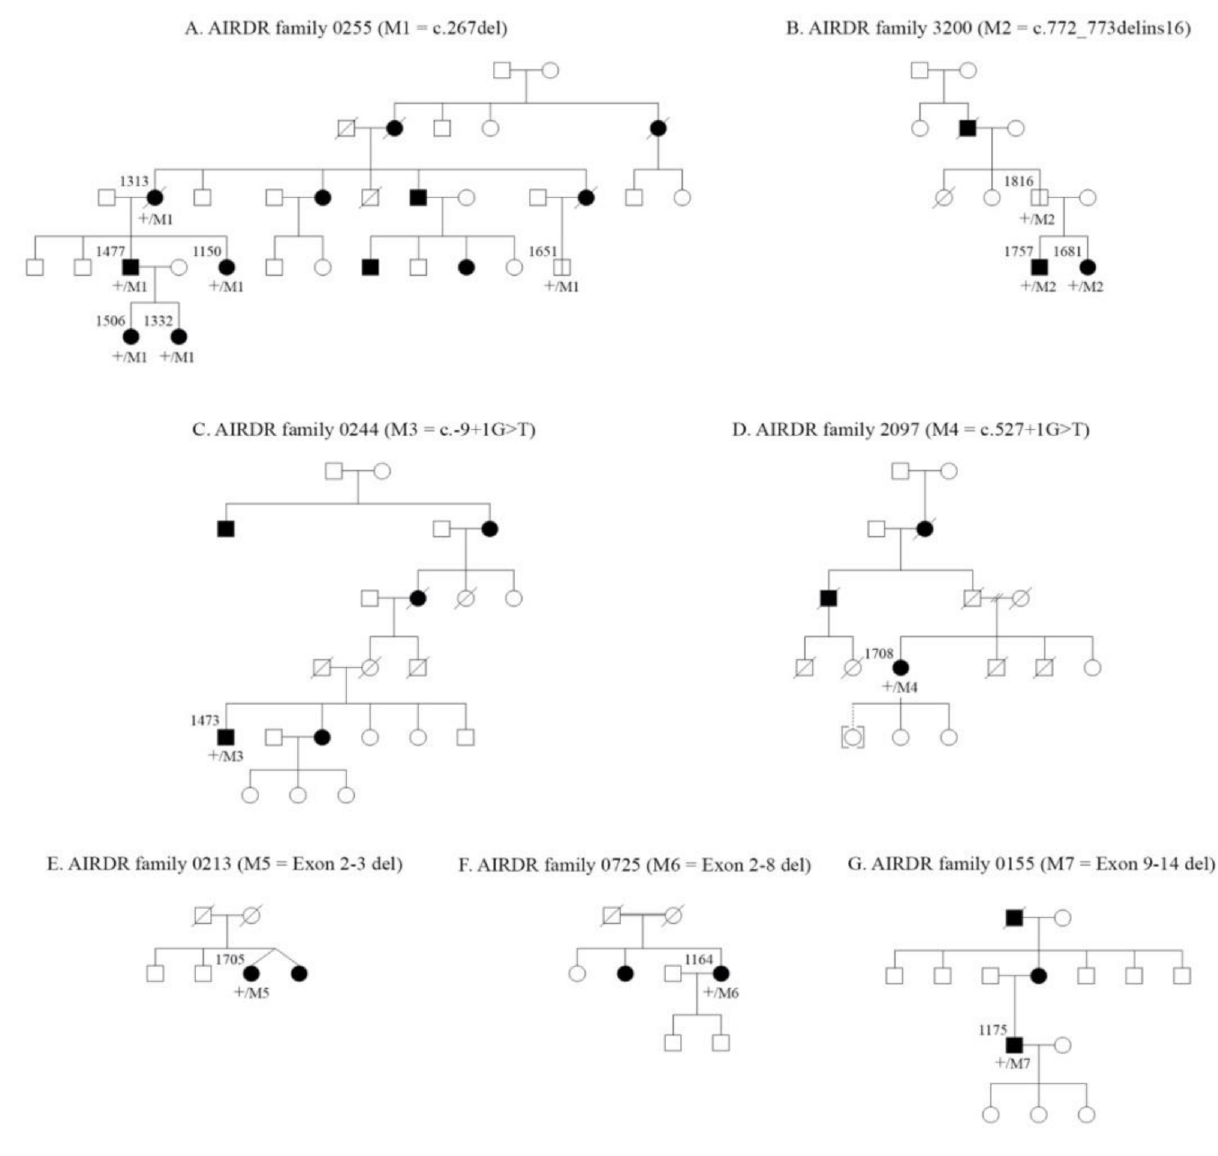
Figure 1. Pedigrees of the autosomal dominant retinitis pigmentosa families diagnosed with PRPF31 -associated retinopathy. Patients enrolled in the present study are marked with WARD study